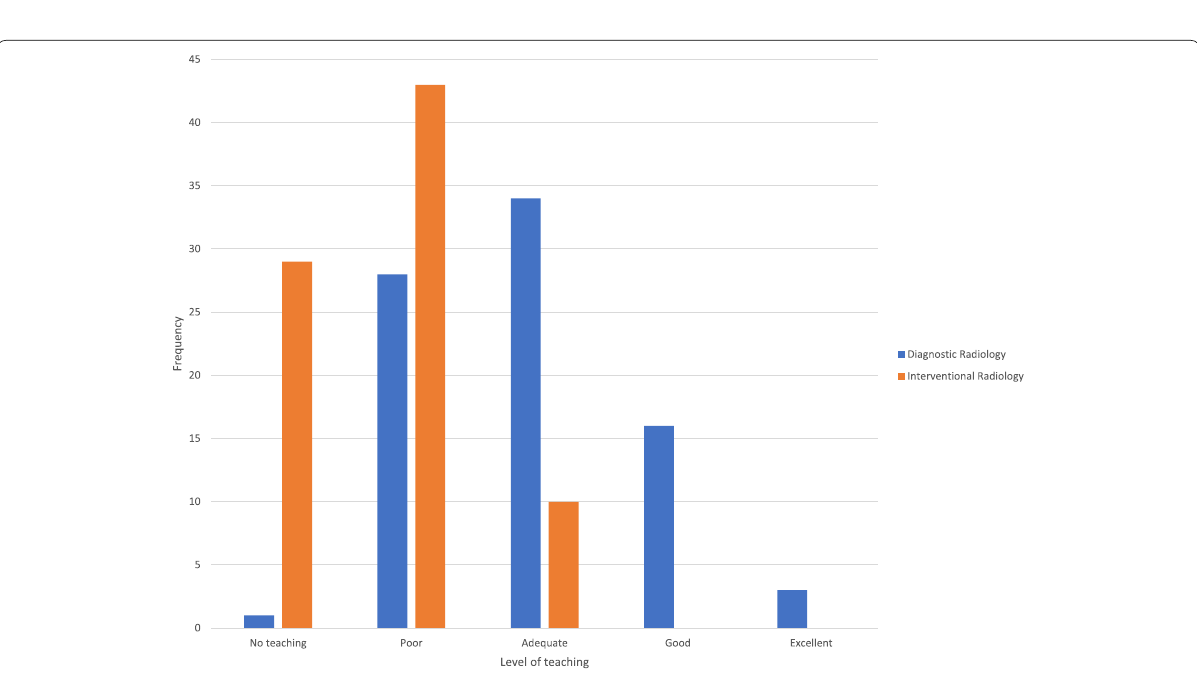
Fig. 2 Bar graph comparing the level of teaching of interventional radiology compared to diagnostic